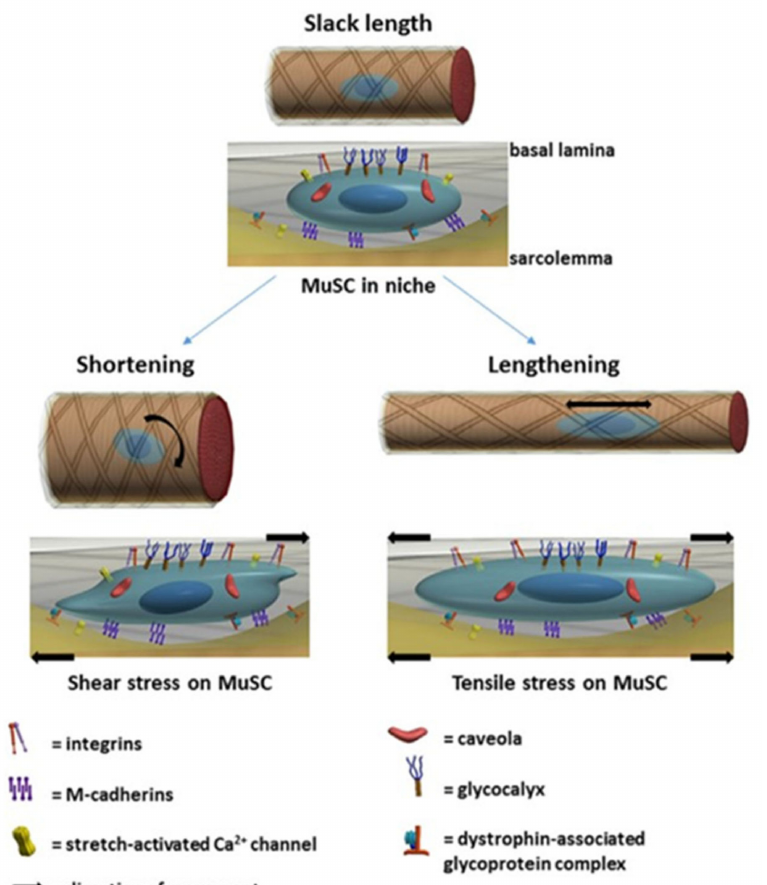
Figure 6. Potential effects of different types of stress on satellite cells. In response to mechanical overload by exercise or stretching, SCs are activated and proliferate to fuse with the host myofibre as shown in Figure 5. Both shear stress through shortening and tensile stress through lengthening may influence satellite cell orientation and deformation. In the unstrained (slack) myofibre is surrounded by a collagen fibre reinforced matrix (top). Below is shown an enlarged lateral view of the SC in its niche between the sarcolemma (yellow) and the basal lamina (BL). Transmembrane proteins anchoring the SC to the sarcolemma include M-cadherins and the dystrophin-associated glycoprotein complex. Both integrins and the glycocalyx anchor it to the BL. Caveolae are invaginations of the plasma membrane which function as message centres for regulating signal transduction and are identified by caveolin-1 which functionally regulates the activation state of caveolae-associated molecules, and which is associated with satellite cells in a more quiescent state [164]. With myofibre shortening, the sarcolemma will move relative to the BL and this is likely to twist the SC from a longitudinal orientation towards a more radial orientation (direction of arrow). As the myofibre is shortening, the sarcolemma and BL are likely moving at varying speeds, the relative movement of the sheaths will impose a shear force onto the SC, with subsequent cellular deformation. Myofibre lengthening will stretch both the sarcolemma and the BL (direction of arrow), which may induce a tensile stress on the SC. These physical cues, some acting through focal adhesion complexes, are thought to mediate the activation and differentiation of SC. Copied from Boers et al., 2018 [38] under the terms of the Creative Commons Attribution